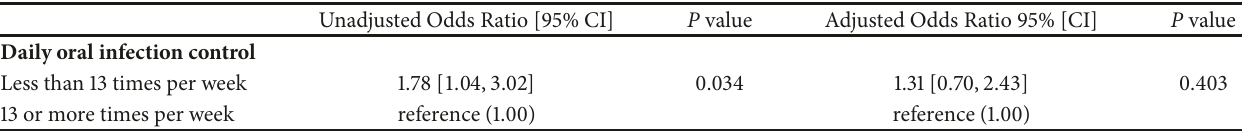
Table 4: Logistic regressions on preterm